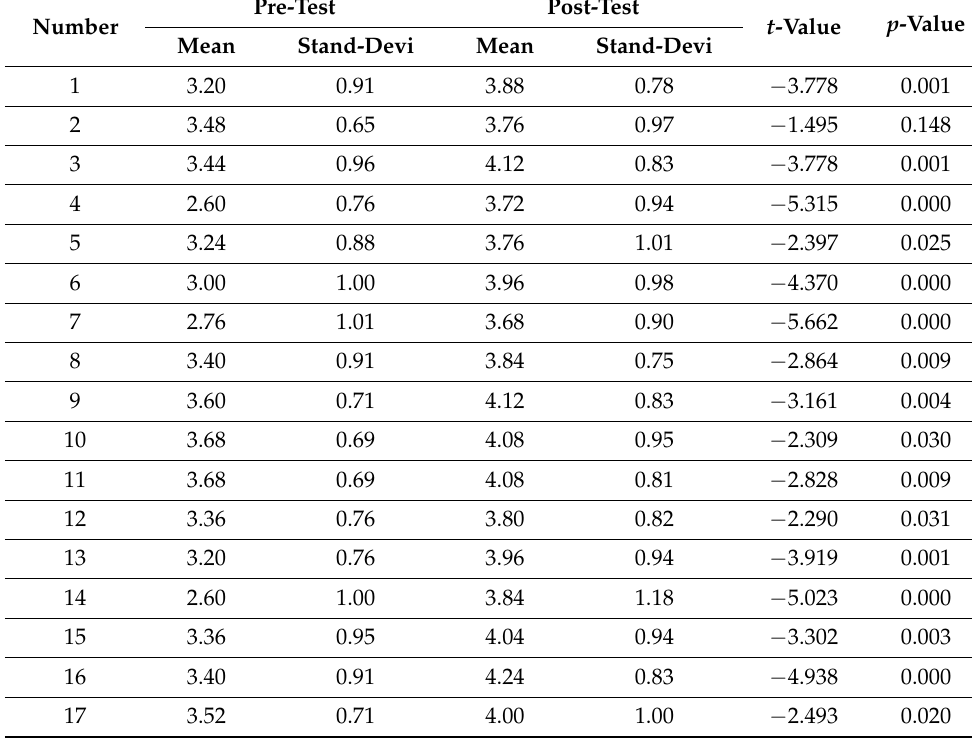
Table 9. Mean, standard deviation of the scores, and t-test result of the questionnaire survey using the EMMR system regarding the removal of the JT9D engine fan blades (n =